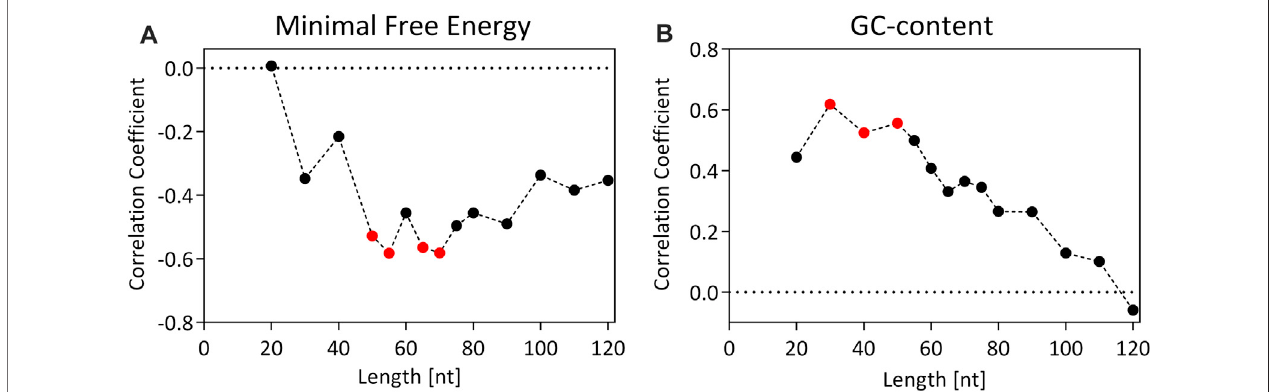
FIGURE5| Correlationcoef fi cient(Spearman ’ sRho)forthecorrelationbetweentheGFPsignal(RFU)andtheminimalfreeenergy(MFE)ofthesecondarystructure (A) or GC-content (B) for 15 different terminator constructs of fi xed lengths. Values of the correlation coef fi cient can range from − 1 to 1. A value of − 1 or 1 suggests a perfect negative/positive correlation, while a value of 0 corresponds to no association between the variables. Red dots indicate statistically signi fi cant correlations ( p <